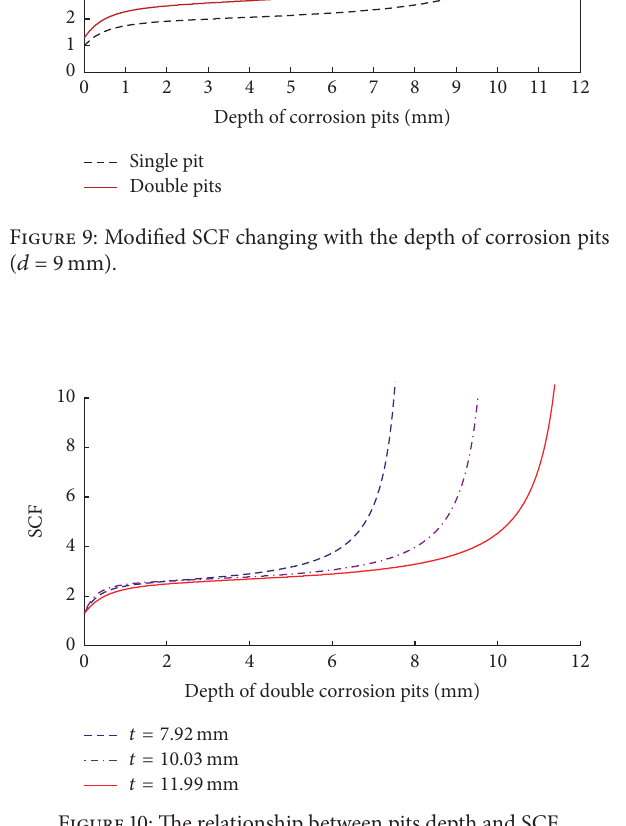
Figure 10: The relationship between pits depth and SCF.